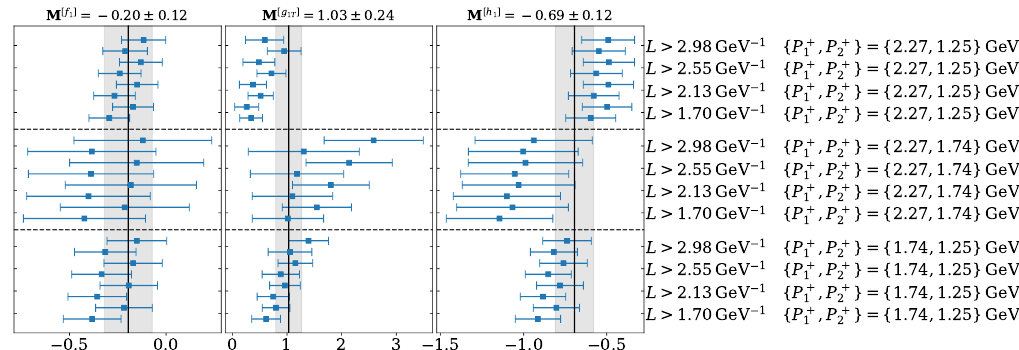
, P + } = { 2 . 27 , 1 . 74 } GeV 1 2